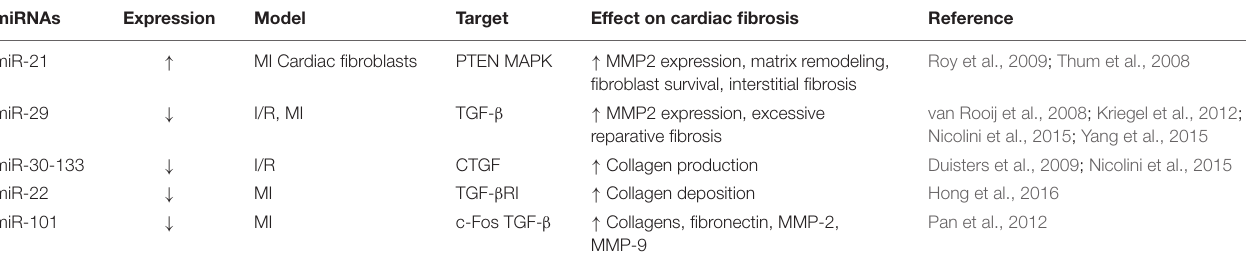
TABLE 2 | Notable miRNAs in cardiac fibrosis; targets and potential therapeutic benefits. miRNAs